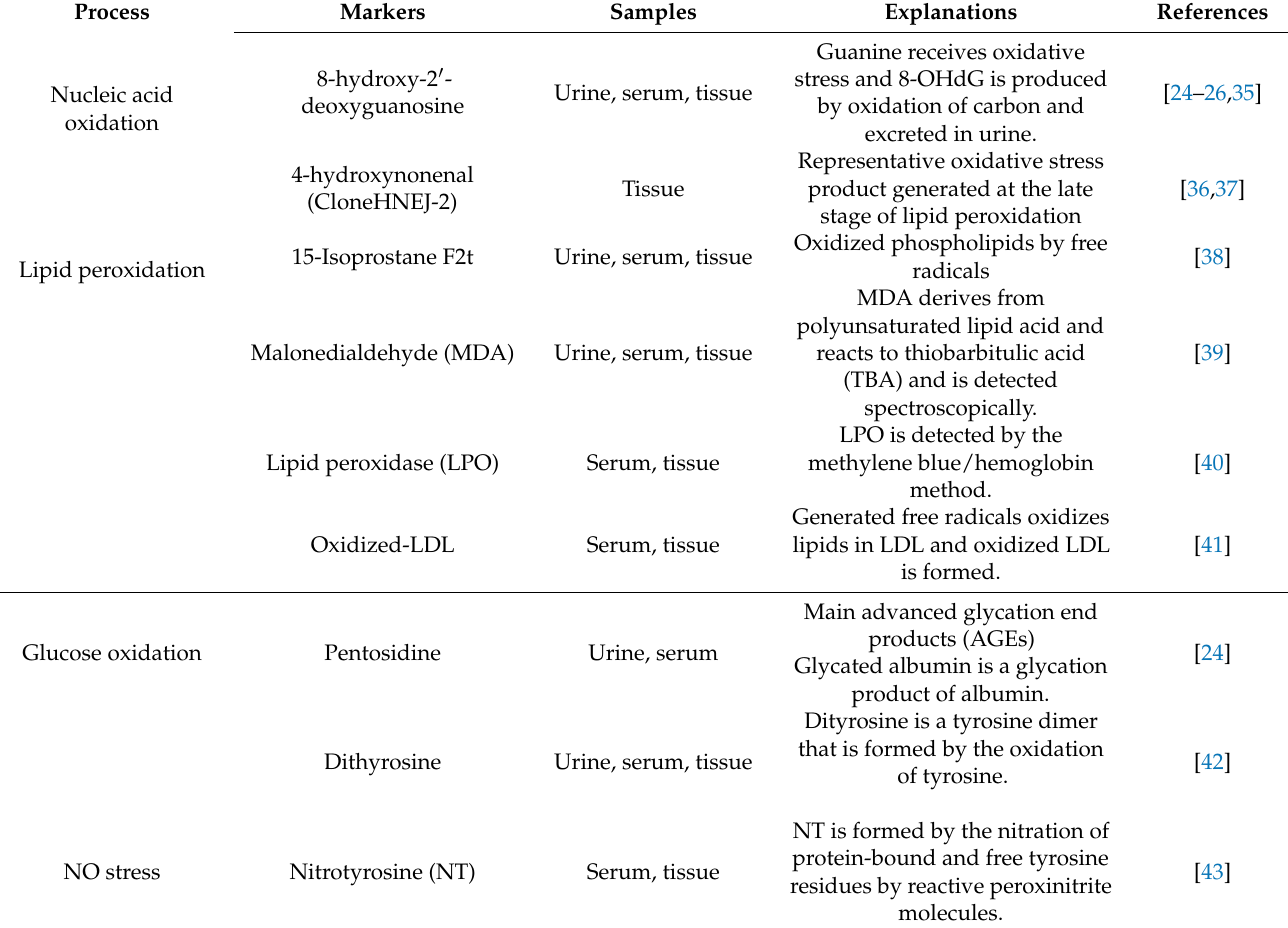
Table 1. Markers of oxidative